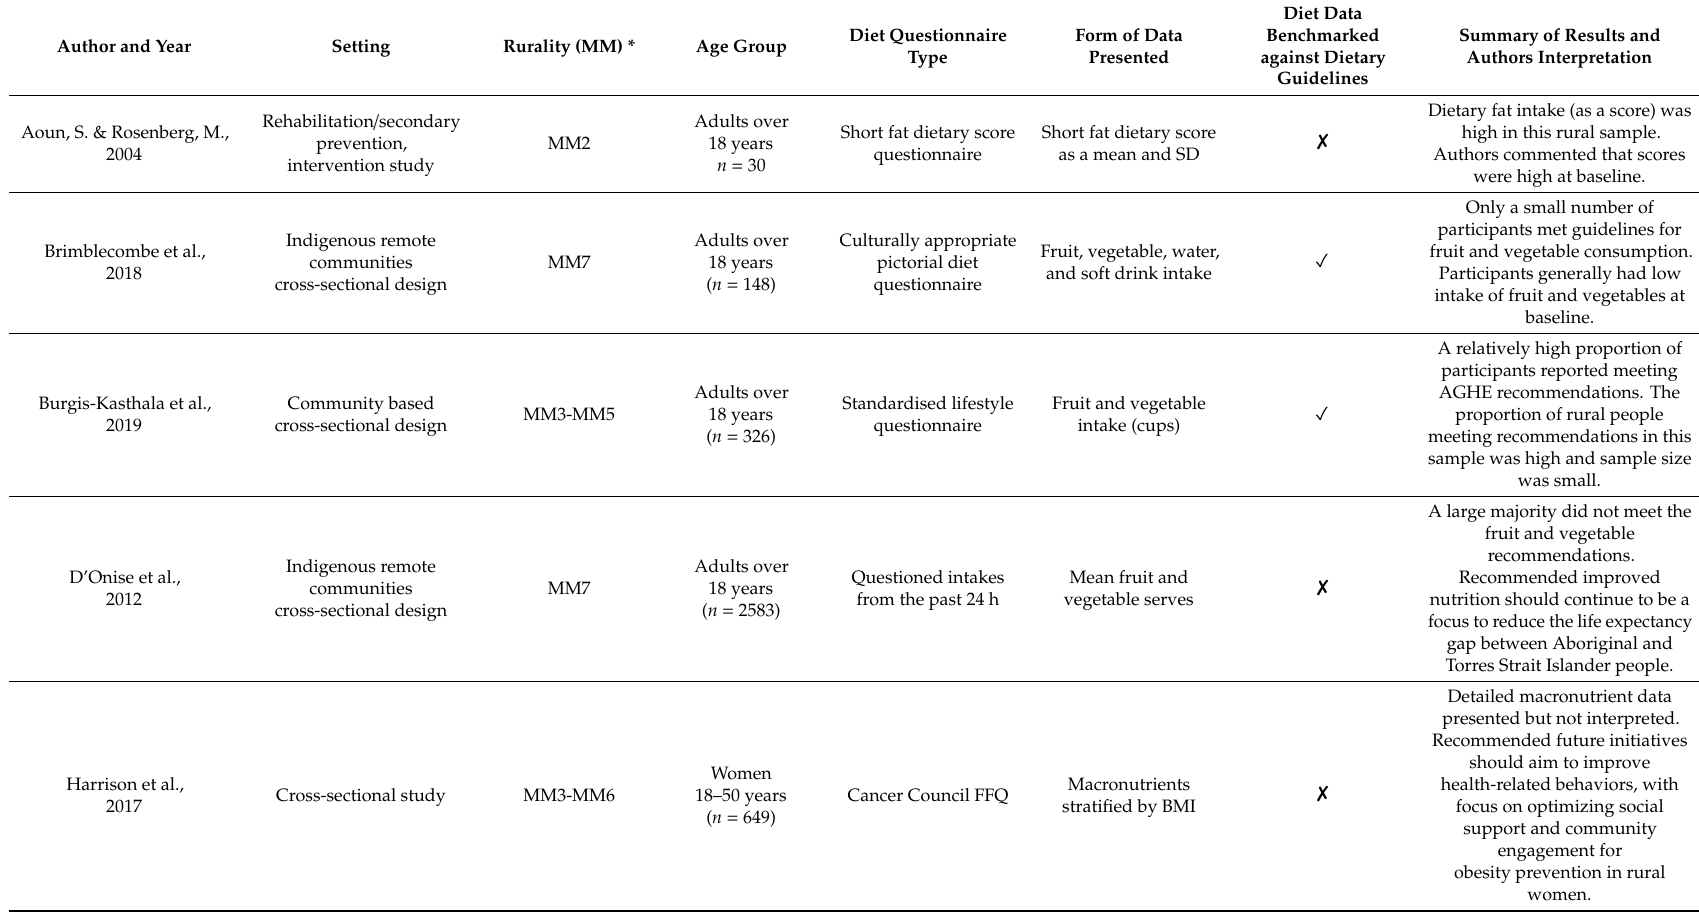
Table 1. Summary of included